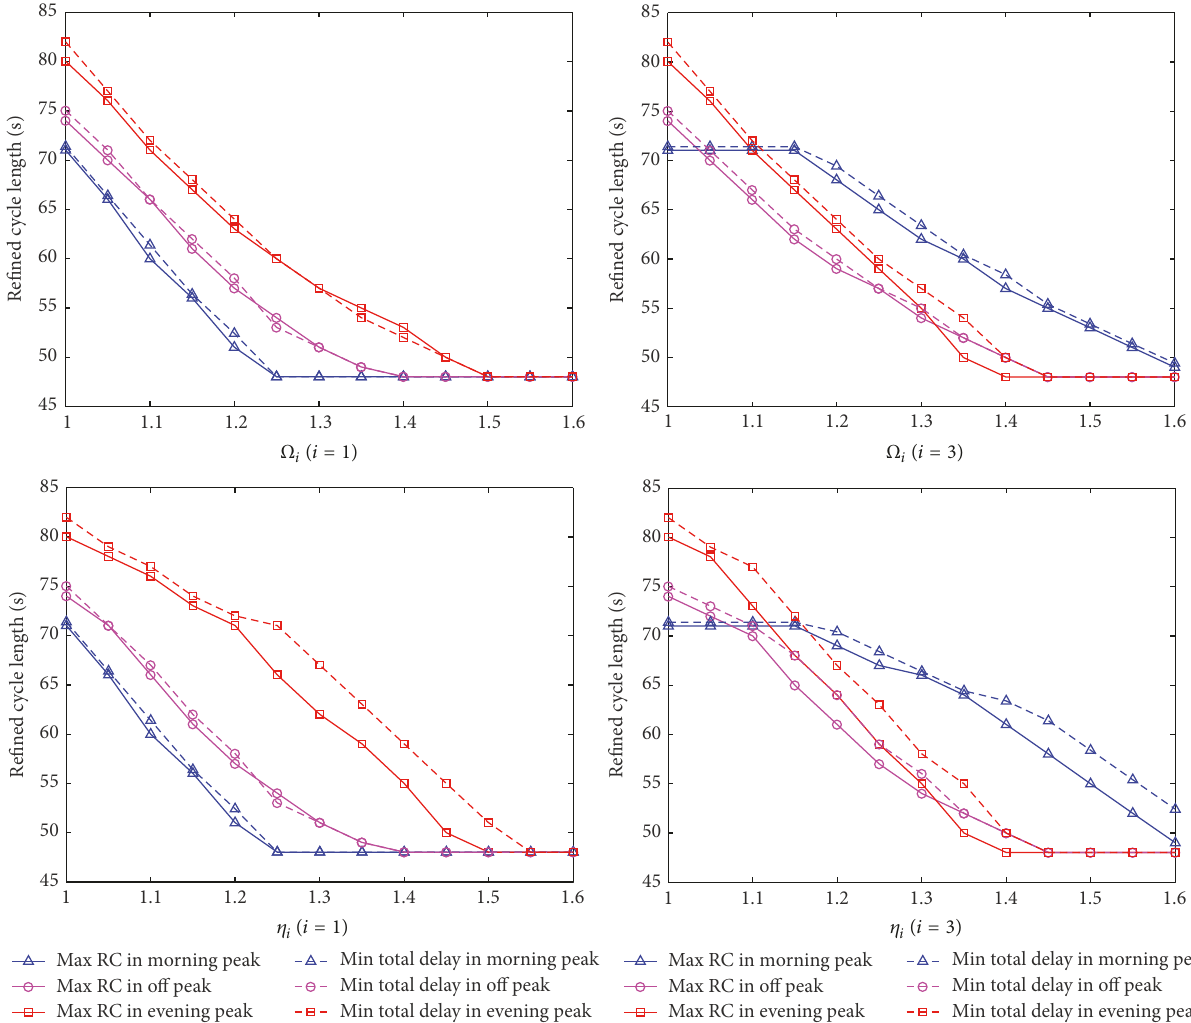
Figure 12: Effect of the road space importance factors Ω 𝑖 (𝑖 = 1, 3) and random arrival influence factors 𝜂 𝑖 (𝑖 = 1,3) on the signal settings refined by the proposed